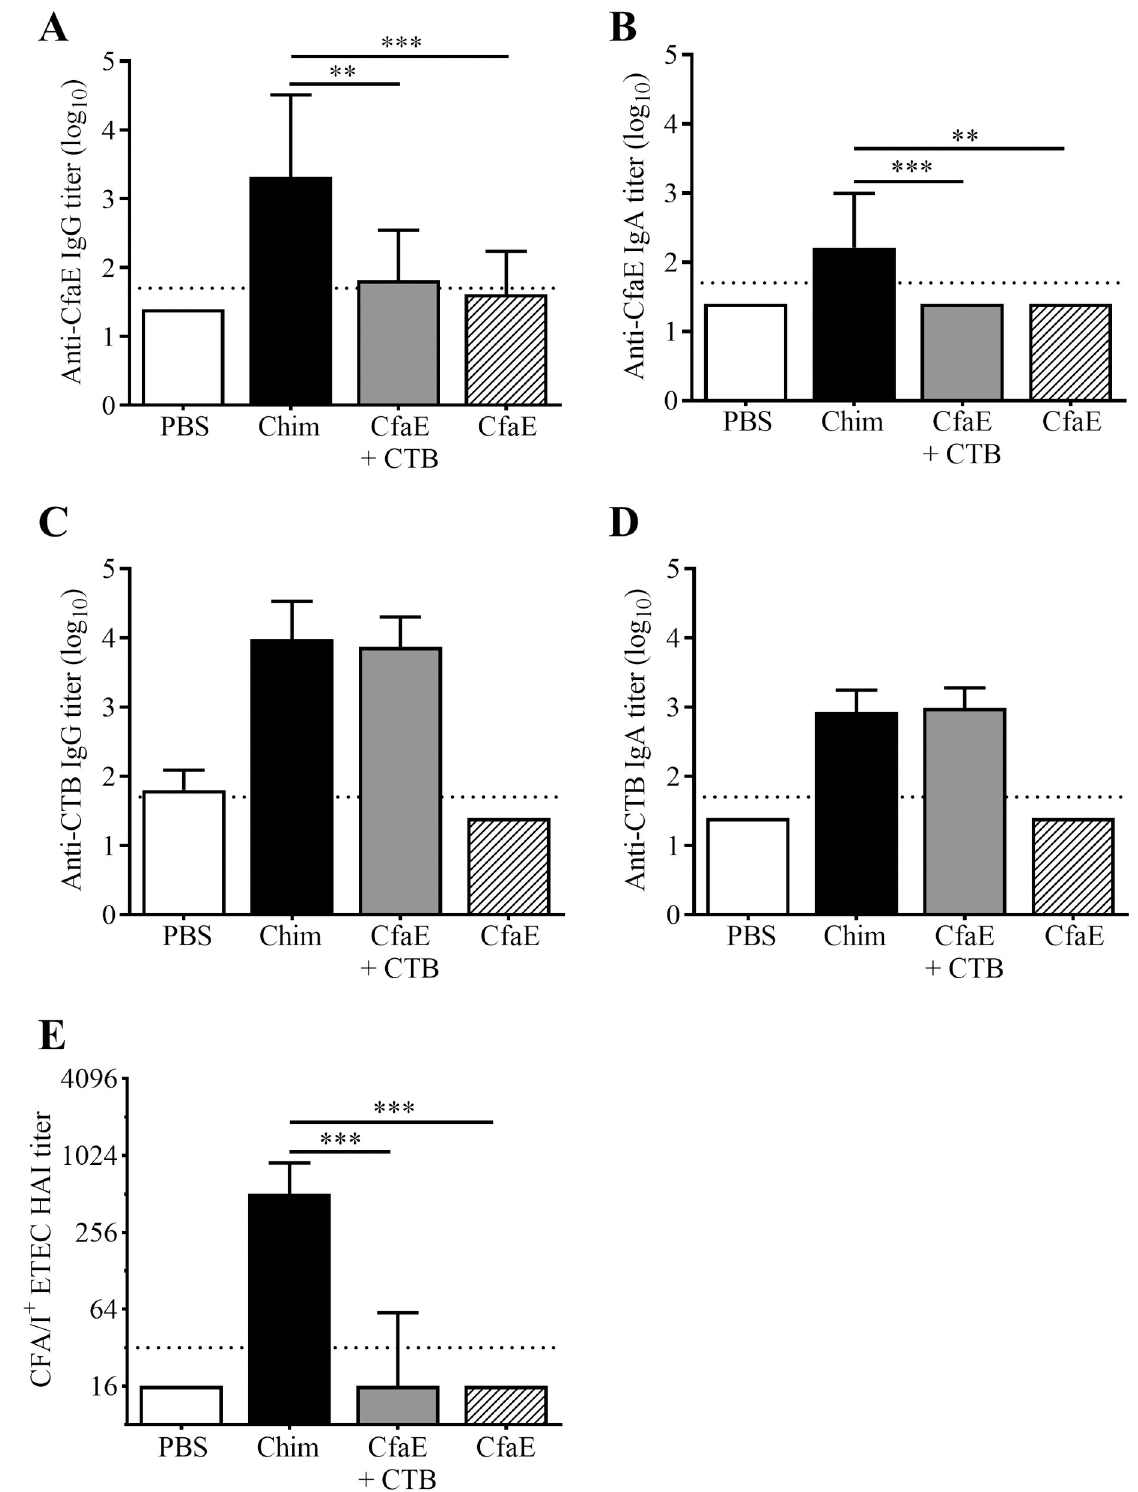
Fig 6. Orogastric immunization with dscCfaE-CTA2/CTB chimera (Chim). Serum antibody responses on day 42 in BALB/c mice vaccinated orogastrically with 162 μ g dscCfaE-CTA2/CTB (black bars), CfaE + CTB admixture containing 62 μ g dscCfaE and 91 μ g CTB (grey bars), 62 μ g CfaE alone (striped bars), or PBS (white bar). The admixture and CfaE groups were molar matched to the approximate